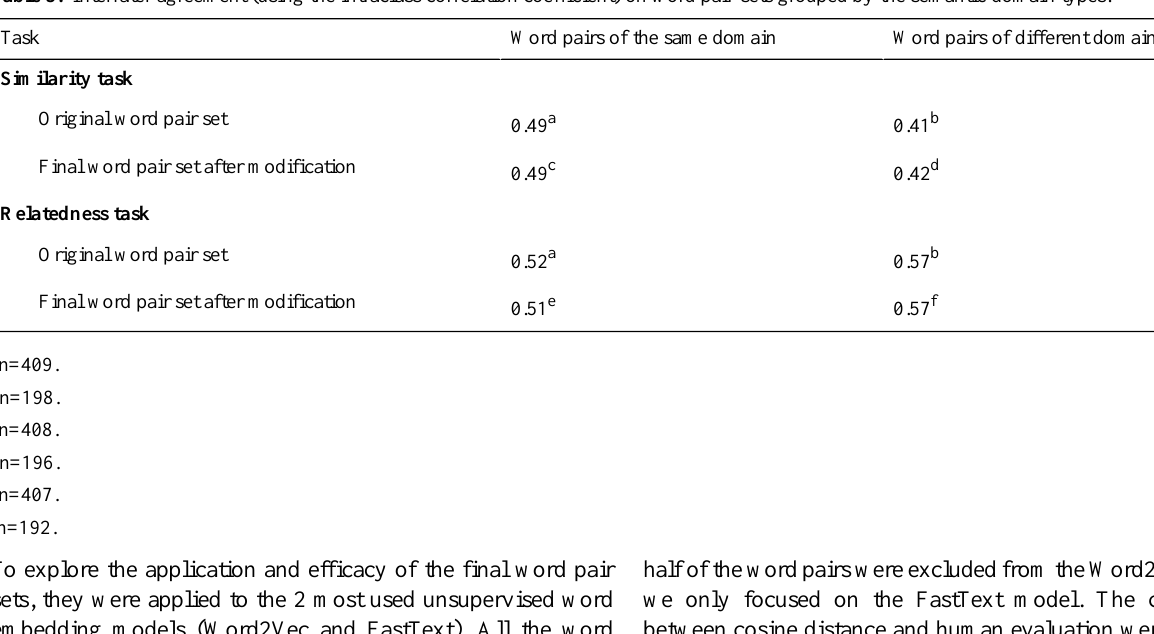
Table 3. Interrater agreement (using the intraclass correlation coefficient) on word pair-sets grouped by the semantic domain types. Similarity task